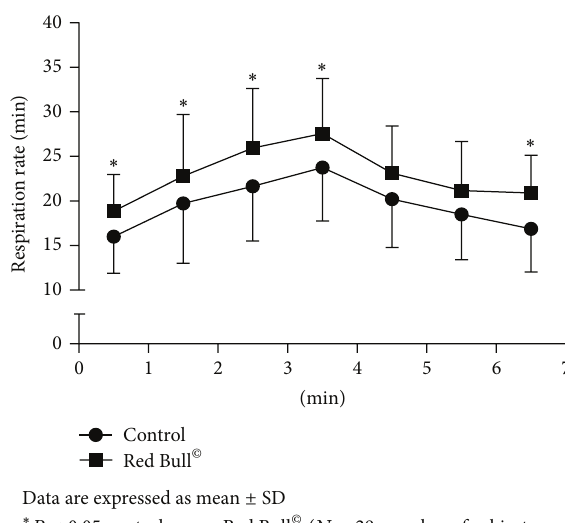
Figure 2: Change of heart rate (HR) during 1-minute rest, 3 minute ofHarvardStepTest,and3-minuterestafterexercisebeforeandafter Red Bull © consumption.